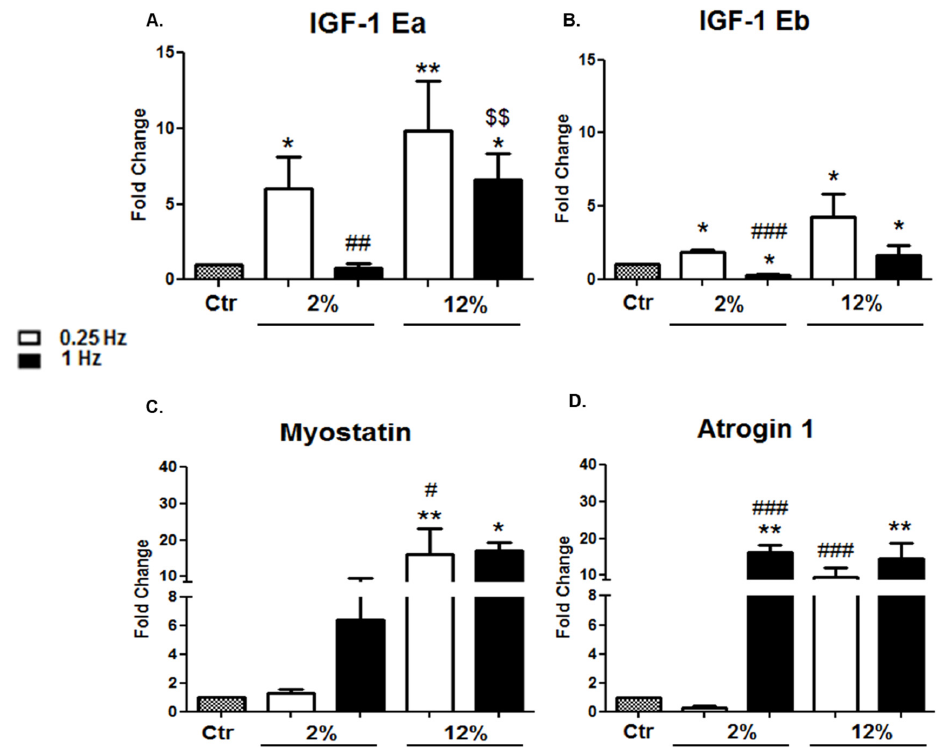
Figure 4. ( A , B ) Effects of mechanical stretching on the expression of the IGF-1 isoforms. Quantita- tive analysis of ( A ) IGF-1Ea and ( B ) IGF-1Eb mRNA levels in differentiated cardiomyocytes